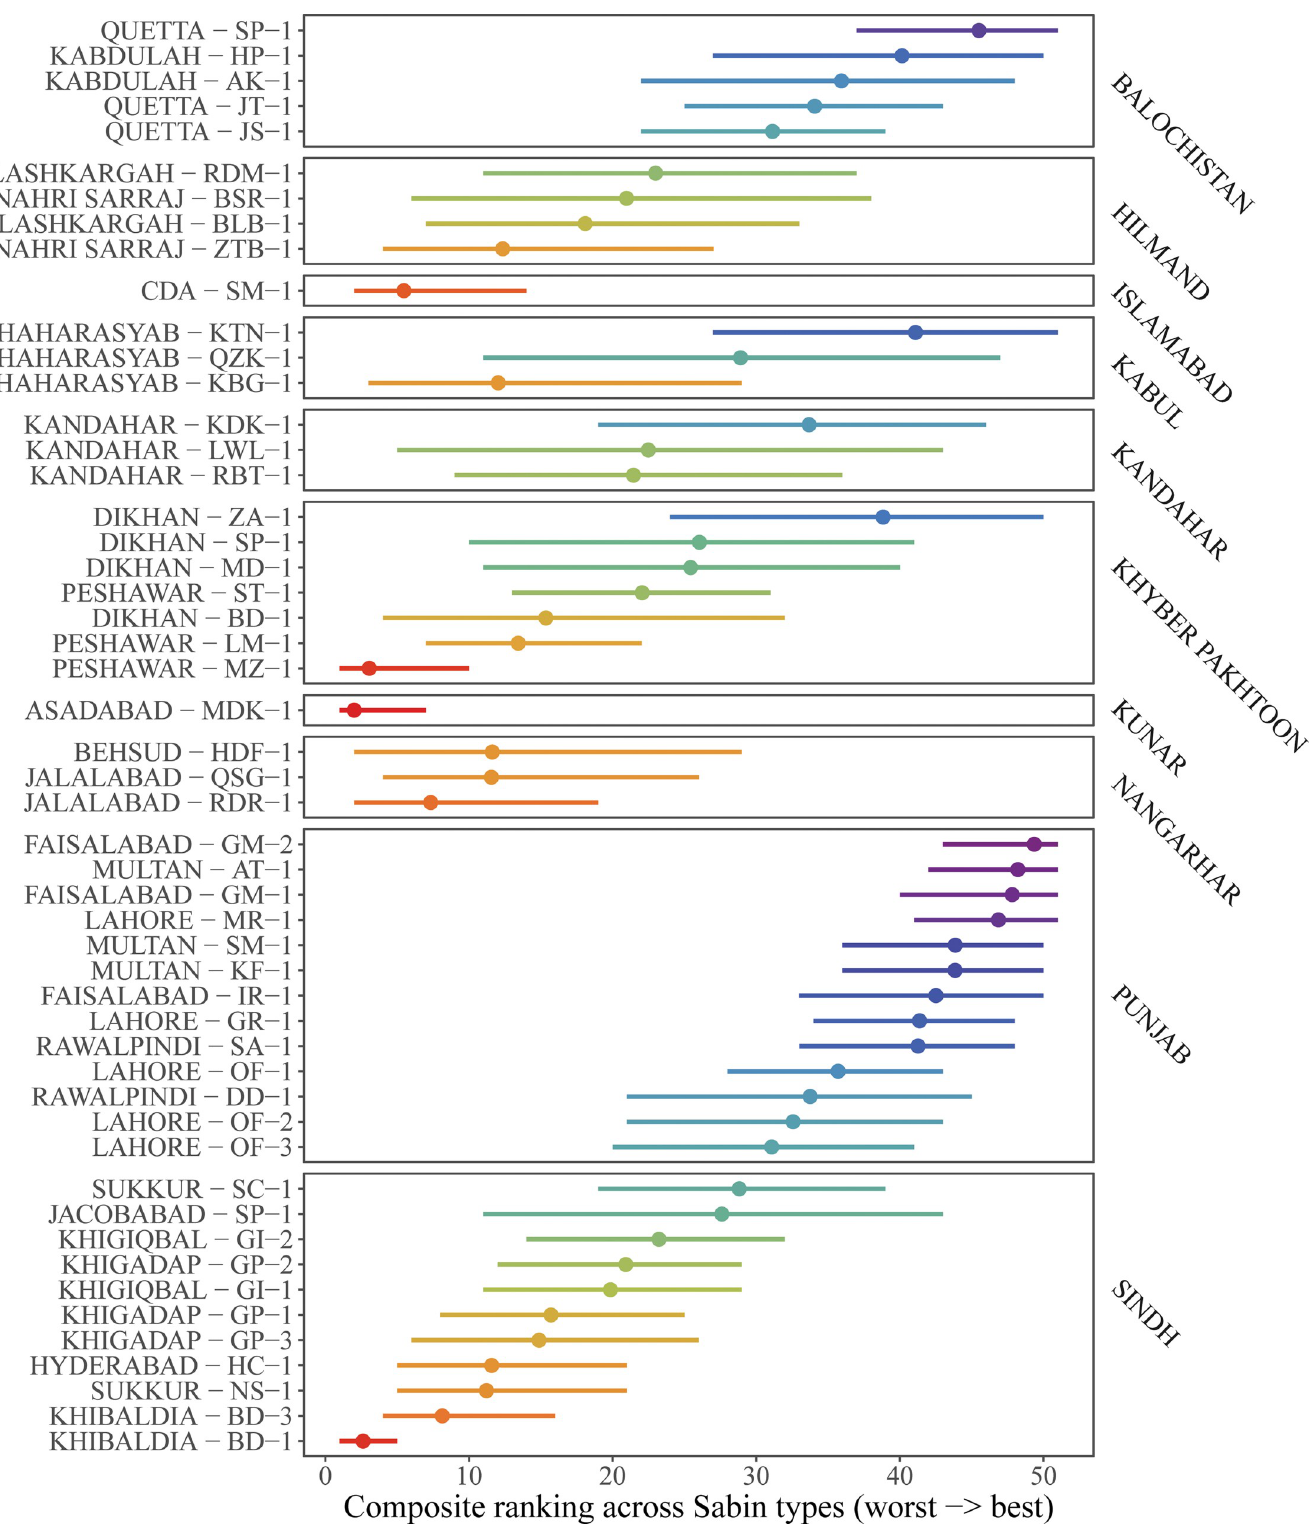
Fig 4. Composite model rankings of ES site sensitivity from least to most sensitive. We averaged rankings across SL1, SL2, and SL3 within each of the 500 model posteriors. Dots indicate the mean rank estimate and bars indicate 95% credible intervals. Sites are colored from least sensitive (red) to most sensitive (purple). ES sites are labeled with the district name and side ID (labels on the left) and grouped at the province level (labels on right). https://doi.org/10.1371/journal.pone.0208336.g004 PLOS ONE | https://doi.org/10.1371/journal.pone.0208336 December28, 2018 9 /